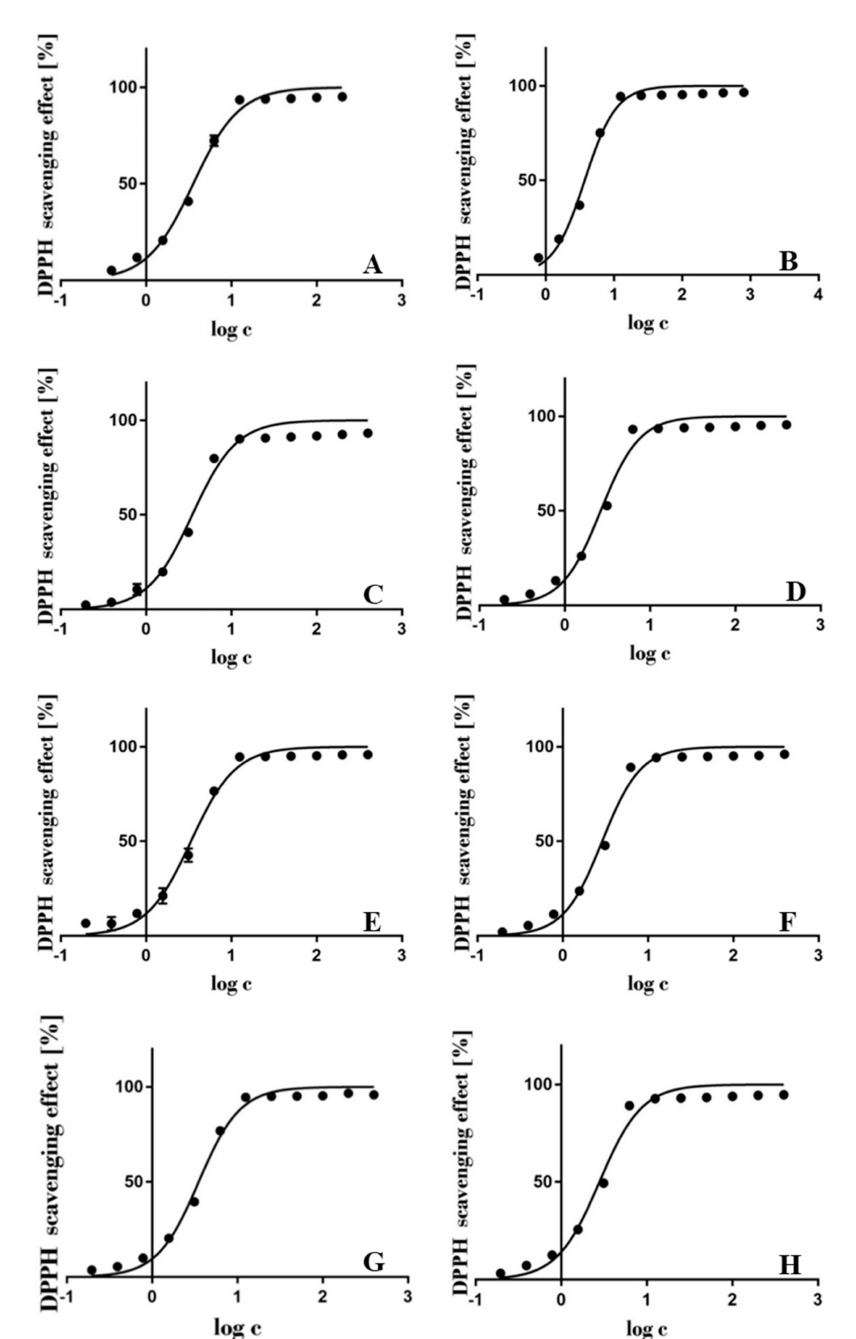
Figure 1. Logarithmic curves of the antioxidant activities of extracts of Japanese knotweed rhizome bark (JKRB) ( n = 3) prepared with the following solvents and solvent mixtures: water ( A ), methanol ( B ), 80% methanol (aq) ( C ), acetone ( D ), 70% acetone (aq) ( E ), ethanol ( F ), 70% ethanol (aq) ( G ), and 90% ethyl acetate (aq) ( H ). The calculated values of IC 50 are 3.561 ( A ), 3.715 ( B ), 3.469 ( C ), 2.632 ( D ), 3.350 ( E ), 2.893 ( F ), 3.503 ( G ), and 2.786 ( H ) µ g mL − 1 (obtained by GraphPad Prism 7